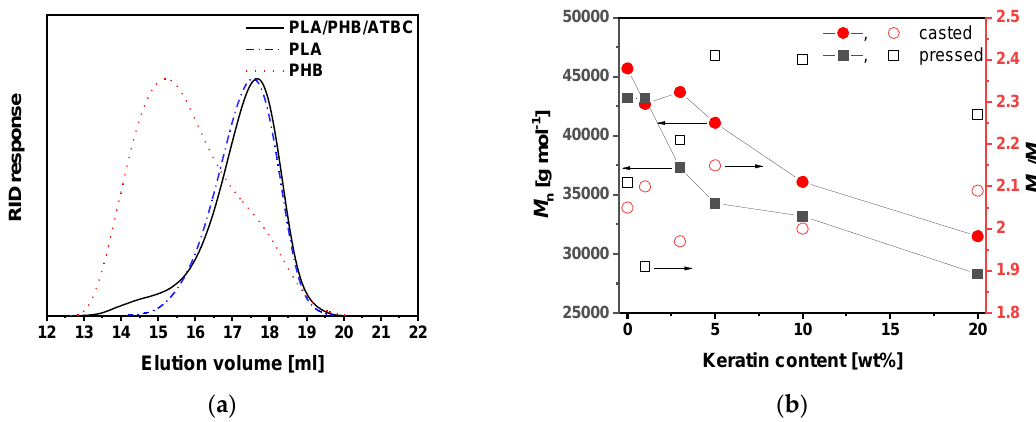
Figure 2. ( a ) GPC traces of PLA/PHB/ATBC blend and related polymers; ( b ) evolution of number average molar masses ( M n ) and dispersity ( Ð ) for casted and compression-molded samples of PLA/PHB/ATBC blend and its keratin composites with different keratin contents varying from 1 to 20 wt%.